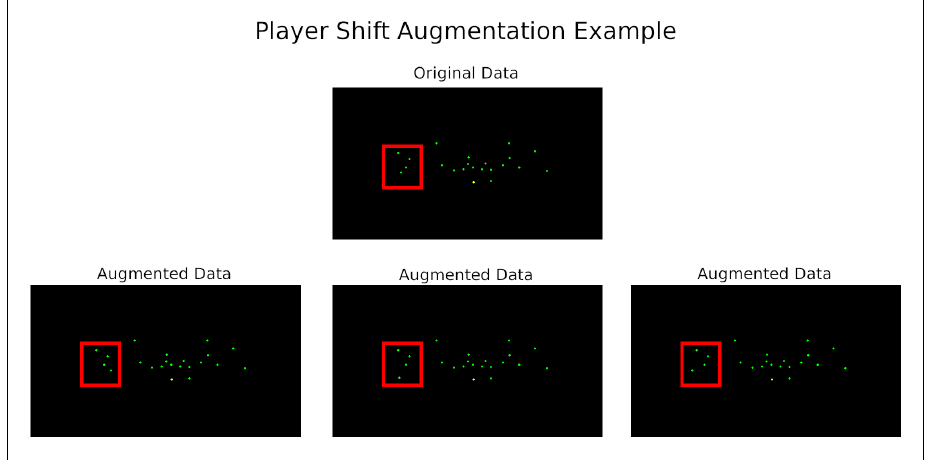
Figure 9. player shifting example—the original player can be shifted multiple times within a specified range of pixels.